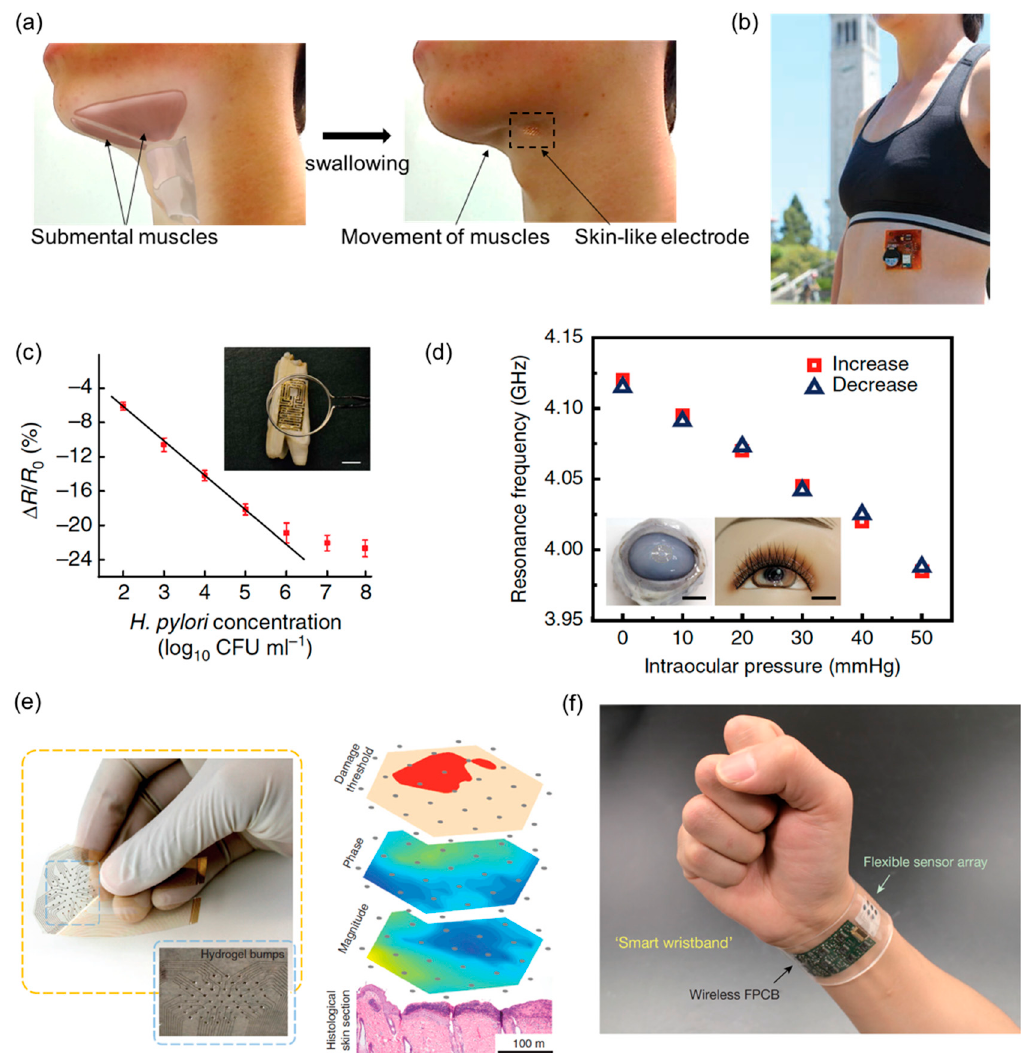
Figure 5. Health monitoring and disease diagnostic systems. ( a ) Illustration of targeted submental muscles on the chin and photos capturing the movement of the muscles upon swallowing activity.